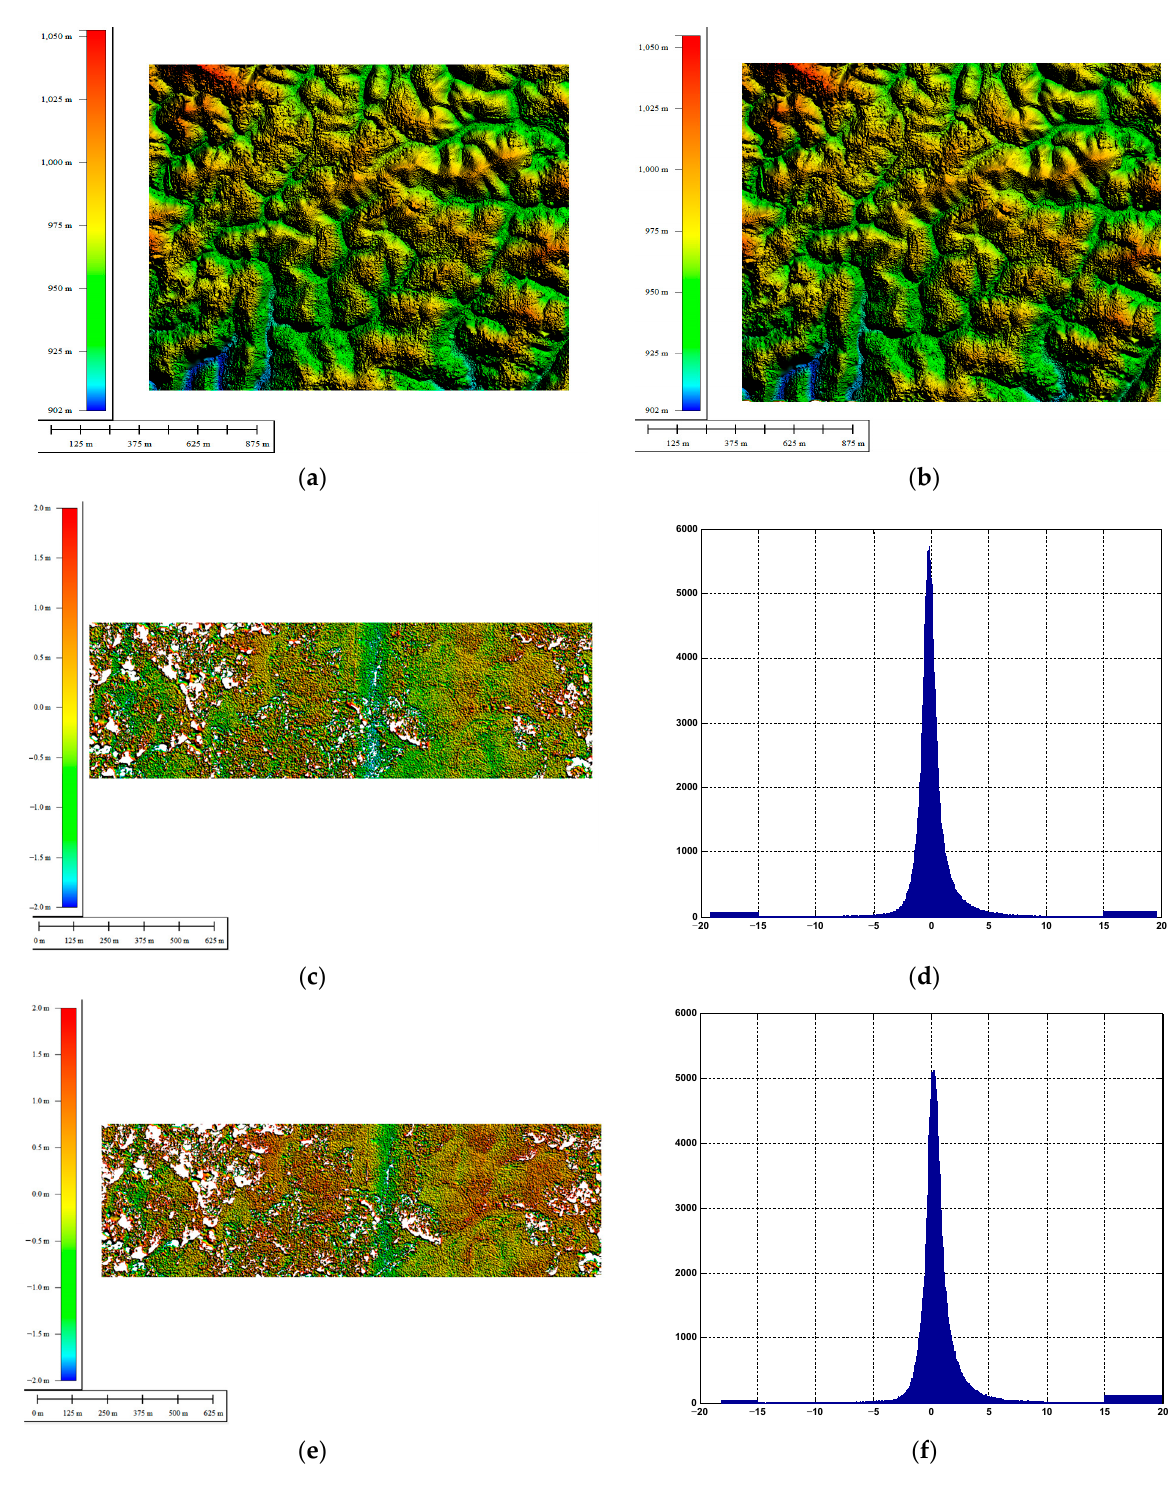
Figure 22. DSM products of strip 5 obtained by elevation inversion, where ( a ) is based on the tie- points, ( b ) is based on marking points, ( c , d ) are the difference and statistical results of two DSMs based on the tie-points, and ( e , f ) are the difference and statistical results of two DSMs based on the marking points. Additionally, the abscissa in ( d , f ) is elevation difference, whose unit is m, and the ordinate in ( d , f ) is the number of pixel points corresponding to relative elevation difference.